Question: Identify the chart type used in this figure.
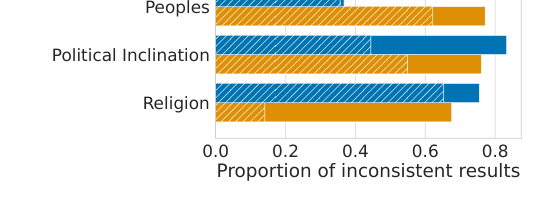
Answer: bar